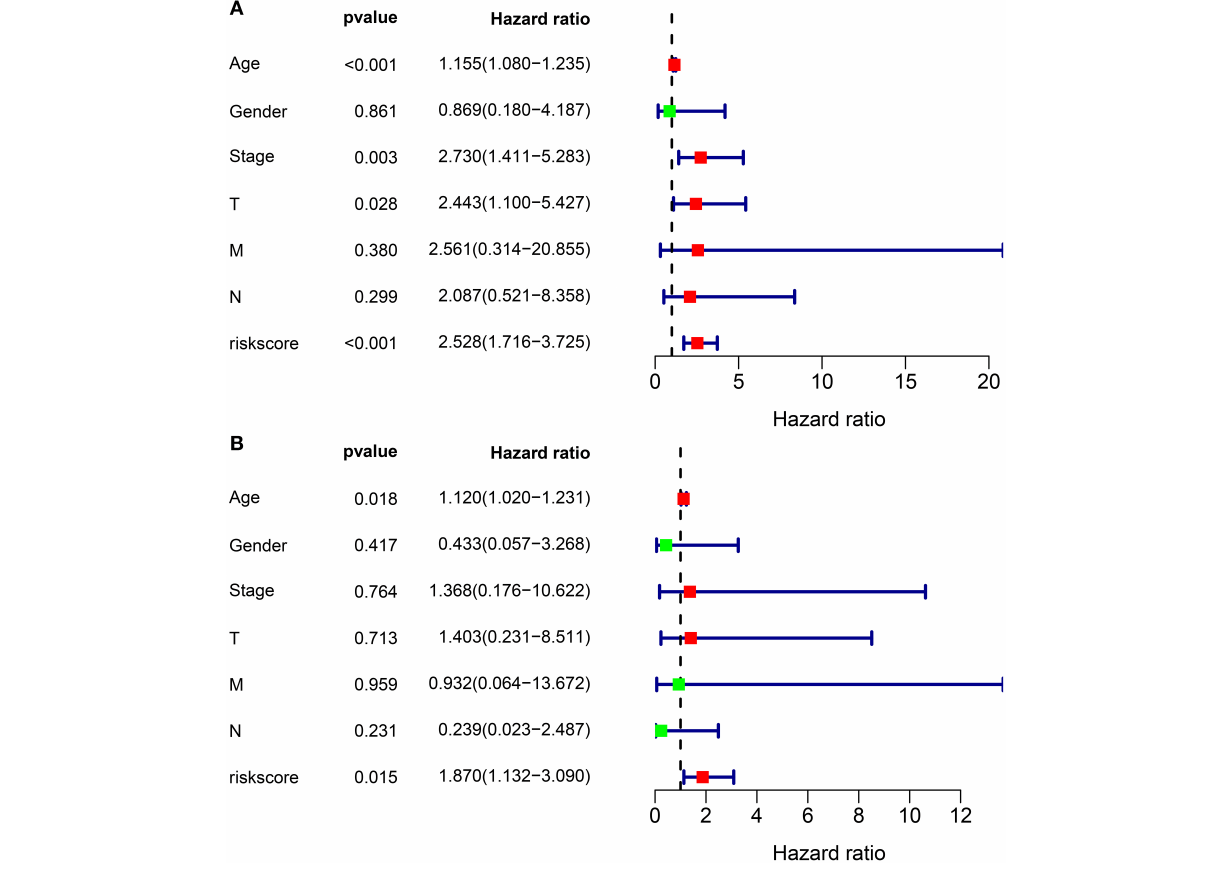
with formaldehyde and stained with crystal violet. The number of invasive cells was